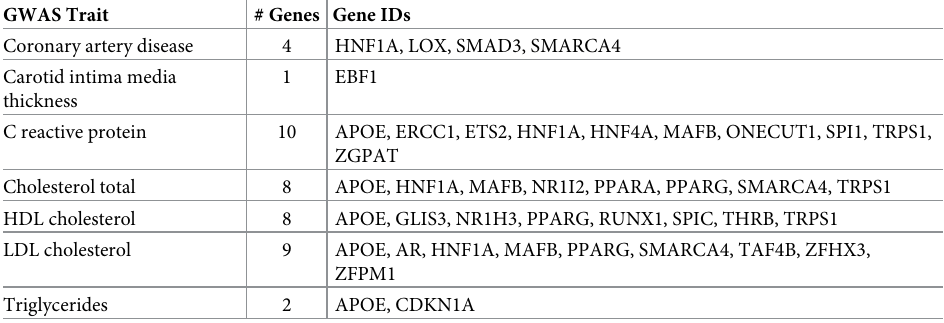
Table 5. Module genes with cardiovascular disease related human GWAS